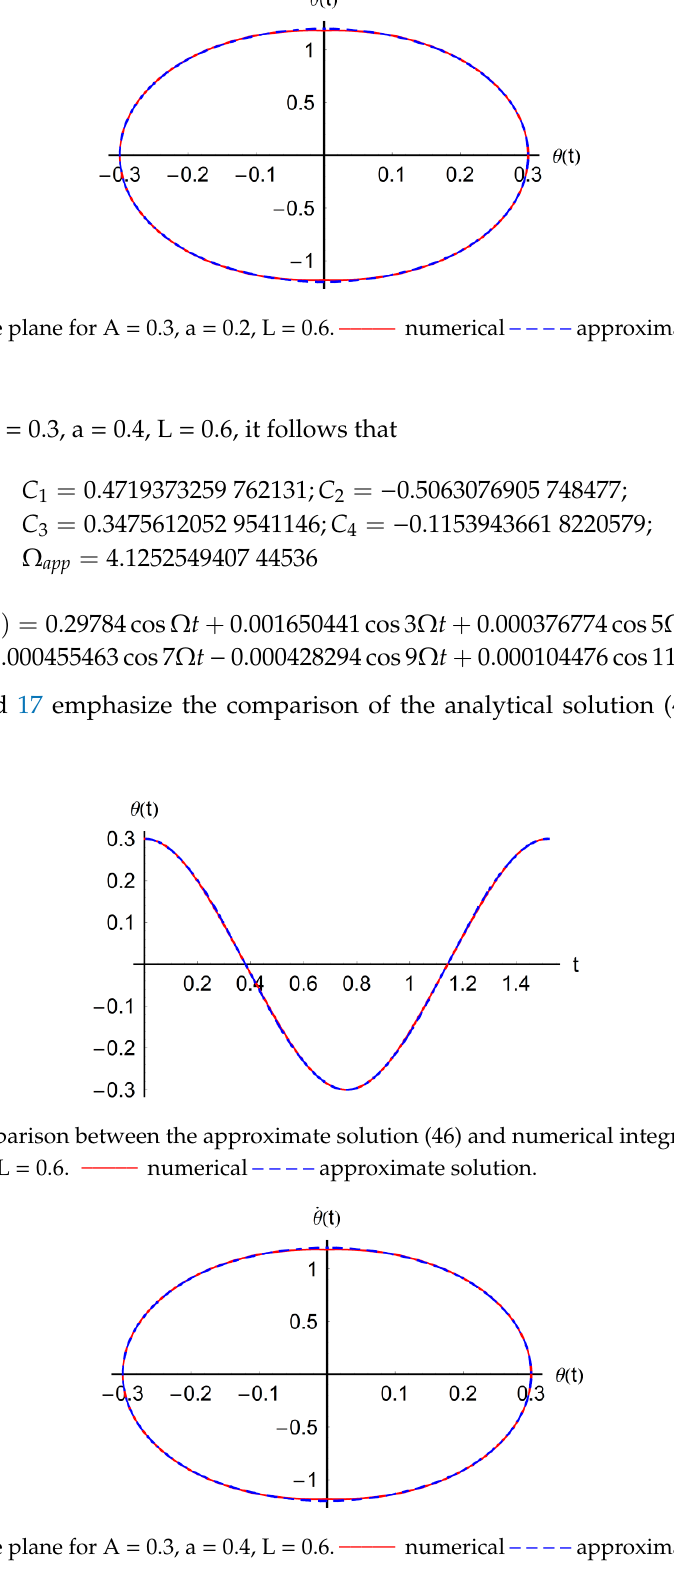
approximate solution